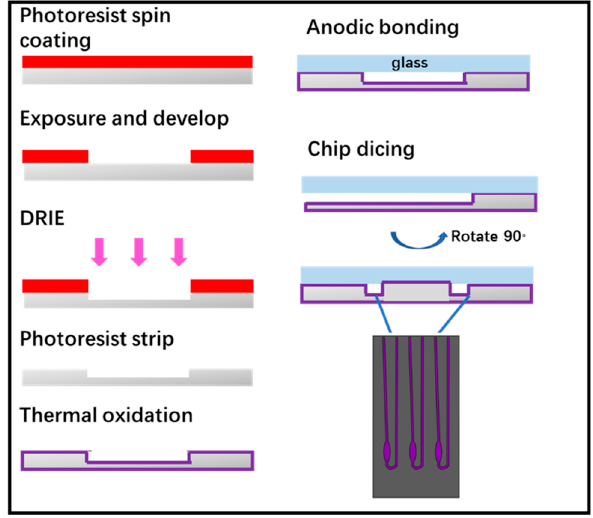
Figure 4. Fabrication process flow of the microchip.